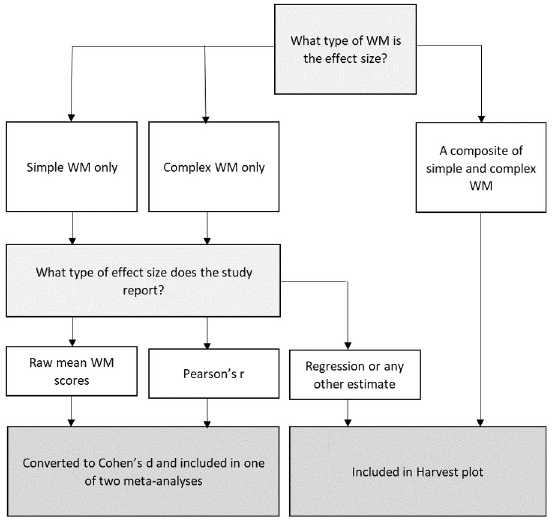
Fig 1. Selection process and eligibility for inclusion in meta-analyses or Harvest